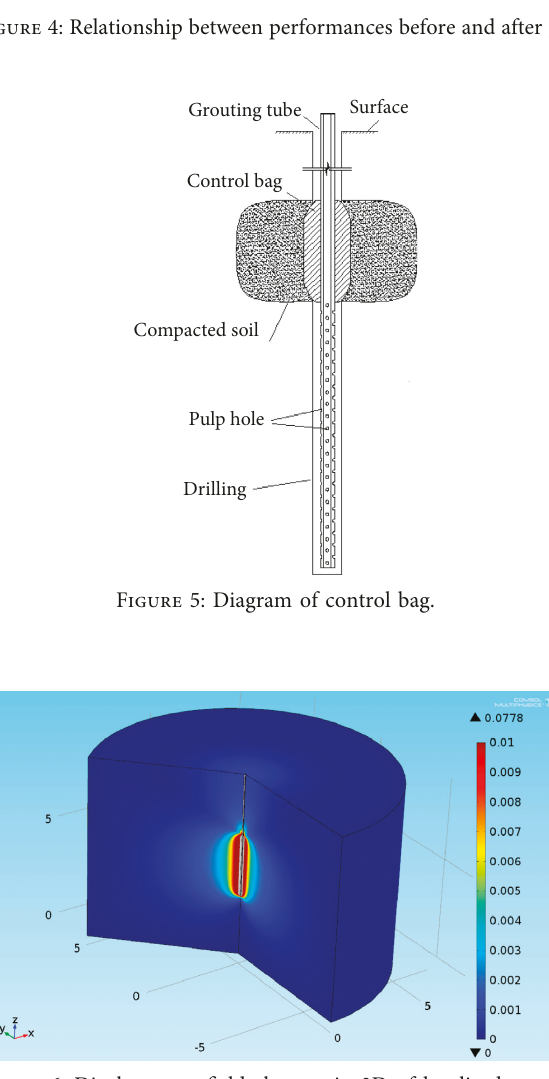
Figure 6: Displacement field changes in 3D of localized control grouting.